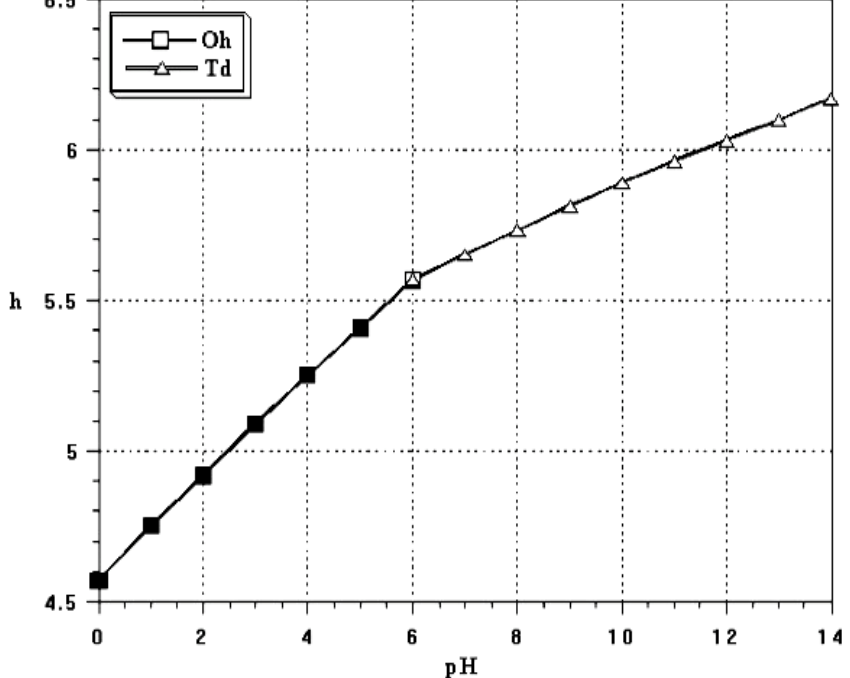
(OH ) ] (5-h)+ as a function of h 2 6-h